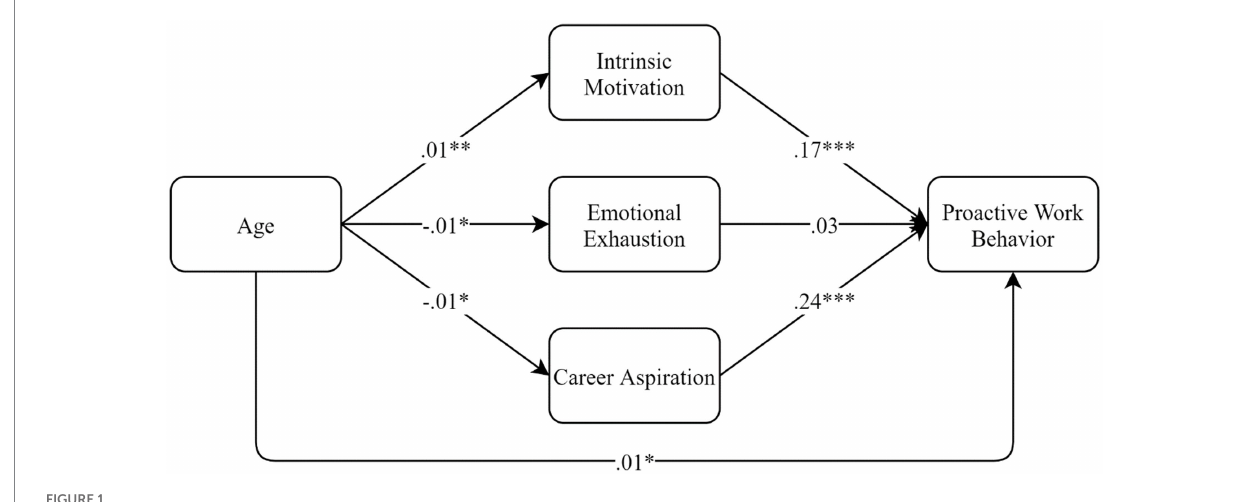
FIGURE 1 Mediation analyses results. * p < 0.05. ** p < 0.01. *** p <